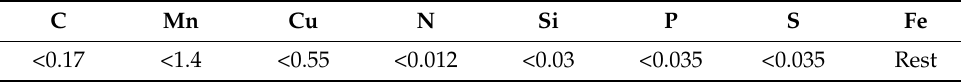
Table 1. Chemical composition of S235JR steel, wt.%, steel standard.